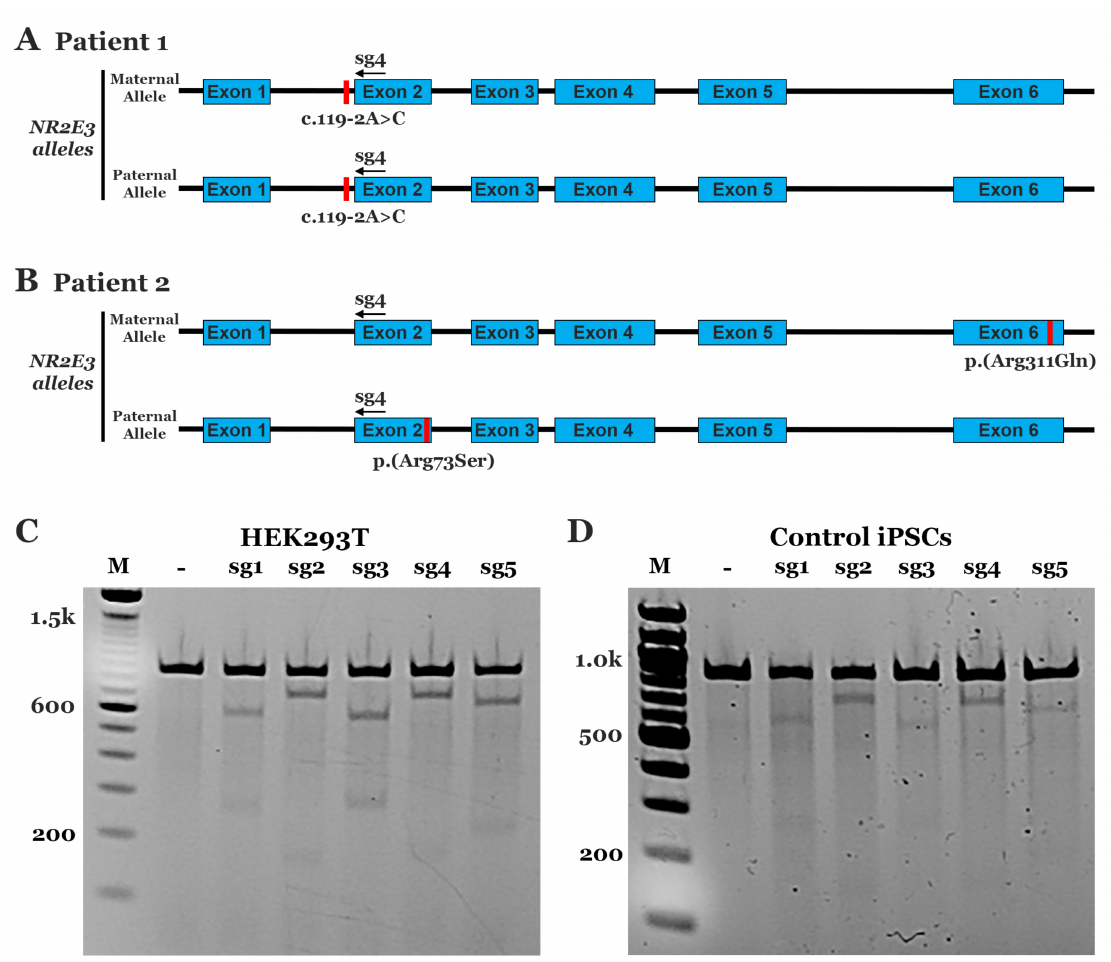
Figure 1. Analysis of CRISPR-Cas9 sgRNA mediated cleavage efficiency. A,B : Schematics depicting genomic disease-causing mutations in Patient 1—homozygous c.119-2A>C mutations ( A ) and Patient 2—compound heterozygous p.(Arg73Ser) and p.(Arg311Gln) mutations ( B ). C,D: Representative gel images of T7E1 assays in HEK293T ( C ) and control induced pluripotent stem cells (iPSCs) ( D ) for 5 different sgRNAs. No transfection control: